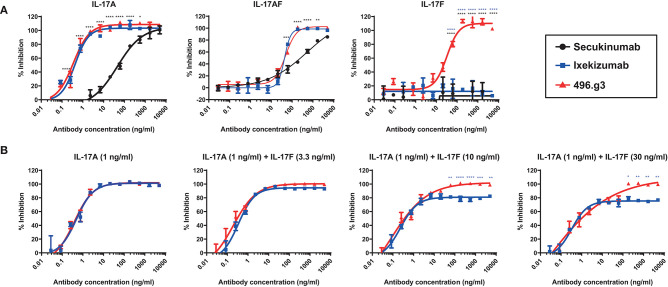
Comparative efficacy of 496.g3 with the approved anti-IL-17A antibodies secukinumab and ixekizumab in inhibiting IL-6 production by normal human dermal fibroblasts (NHDFs). As seen in panel (A) 496.g3 was the only antibody that inhibited IL-6 production in response to stimulation by all three cytokines. In panel (B), 496.g3 maintained complete inhibition of IL-6 production, while the efficacy of ixekizumab declined with each stepwise increase in the ratio of IL-17F to IL-17A. Potency curves were calculated relative to NHDFs activated with TNF alone. In both sets of experiments, IL-17A (1 ng/mL), IL-17A/F (30 ng/mL), or IL-17F (30 ng/mL) in combination with TNF (1 ng/mL) were pre-incubated with titrations of 496.g3, ixekizumab (A,B) and secukinumab (A) for 1 h before addition to NHDFs. The cells were subsequently stimulated for 18–20 h before IL-6 protein levels in the supernatant were determined by homogeneous time-resolved fluorescence. Each condition was tested in duplicate and the data shown is representative of three separate experiments. Two-way ANOVA, Bonferroni post-test analysis was performed to compare inhibition of 496.g3 vs. secukinumab (black stars) or ixekizumab (blue stars) (* p < 0.05, ** p < 0.01, * p < 0.001, **** p < 0.0001).